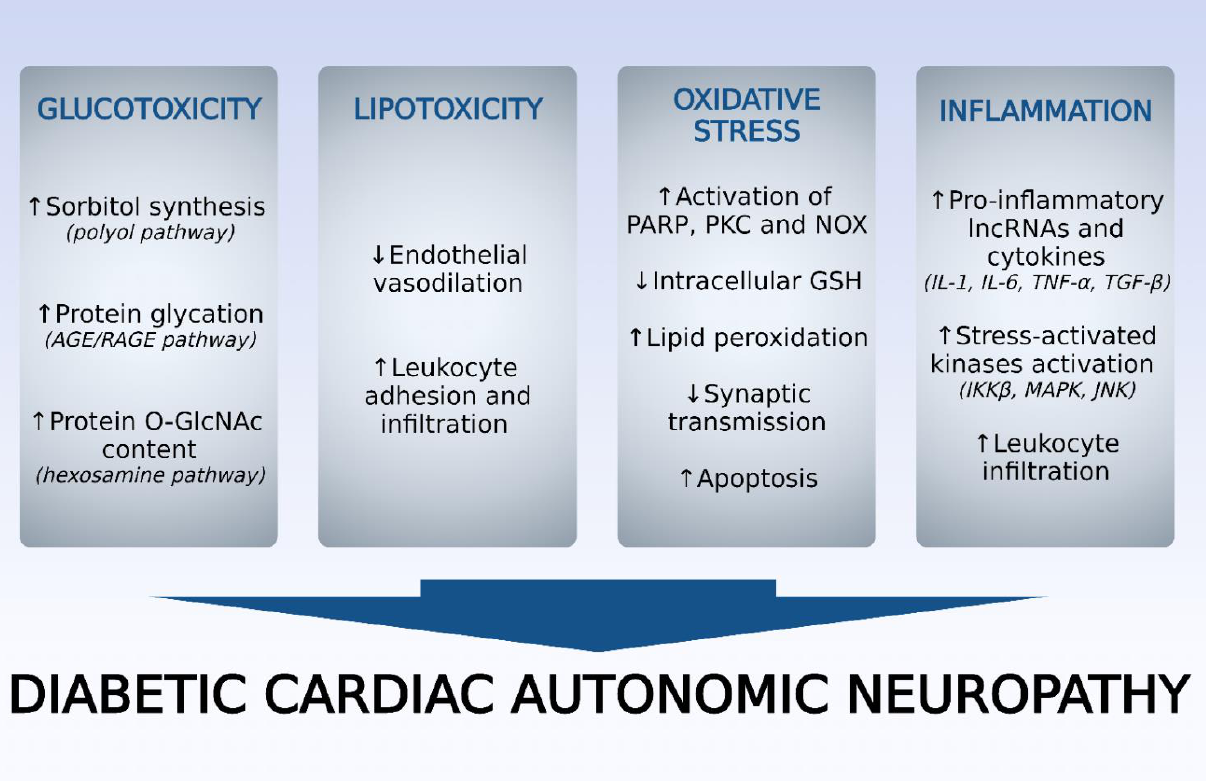
Figure 2. Pathophysiological factors underlying the development and aggravation of diabetic cardiac autonomic neuropathy (DCAN). AGE, advanced glycation end-products; RAGE, receptor for advanced glycation end-products; GlcNAc, N -acetyl glucosamine; PARP, poly(ADP-ribose) polymerase; PKC, protein kinase C; NOX, reduced nicotinamide adenine dinucleotide phosphate oxidase; GSH, reduced glutathione; IL, interleukin; TNF- α, tumor necrosis factor - α; TGF - β, transforming growth factor- β; IKKβ, inhibitor of nuclear factor kappa B kinase; MAPK, mitogen -activated protein kinase; JNK, c-Jun N-terminal kinase. Source: Own authorship.